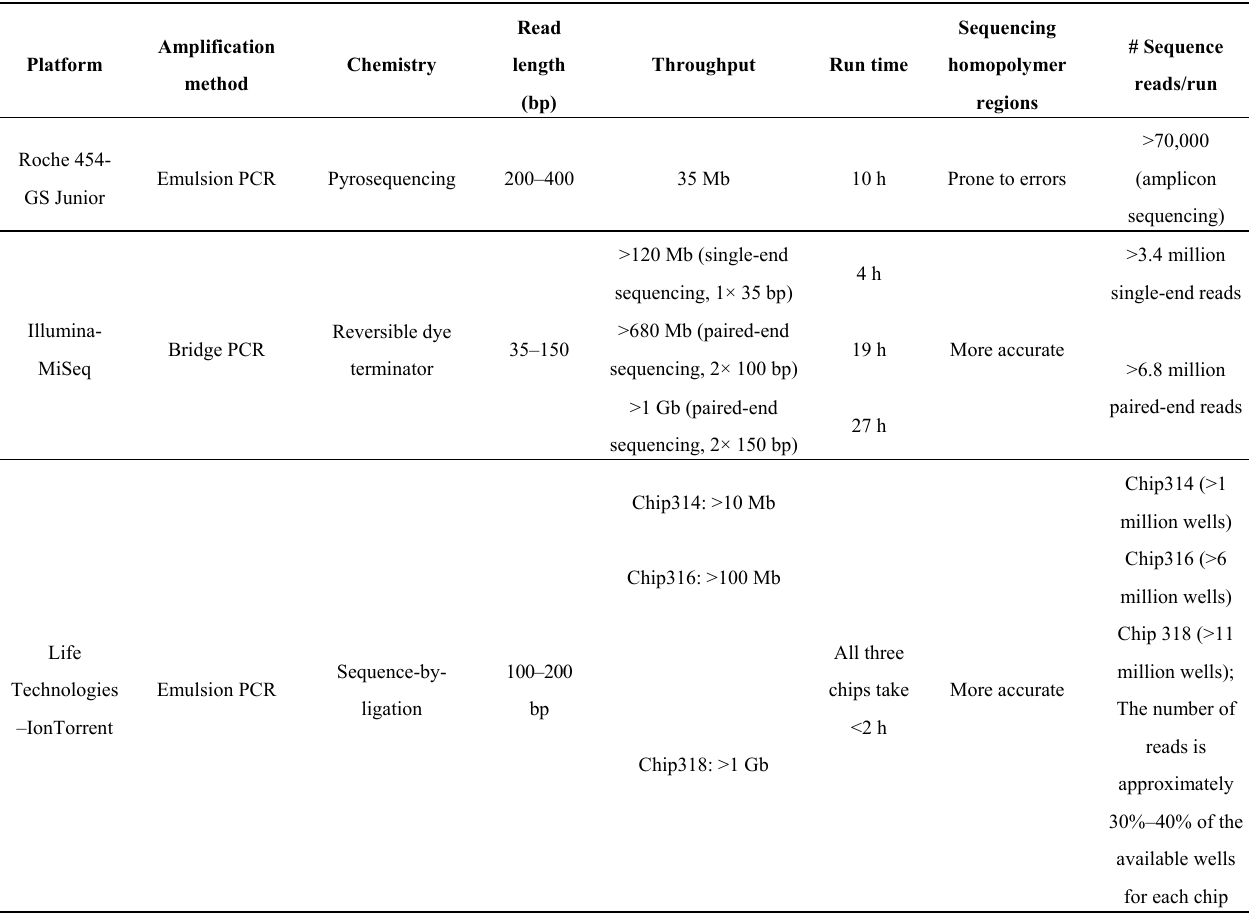
Table 2. Second generation sequencing